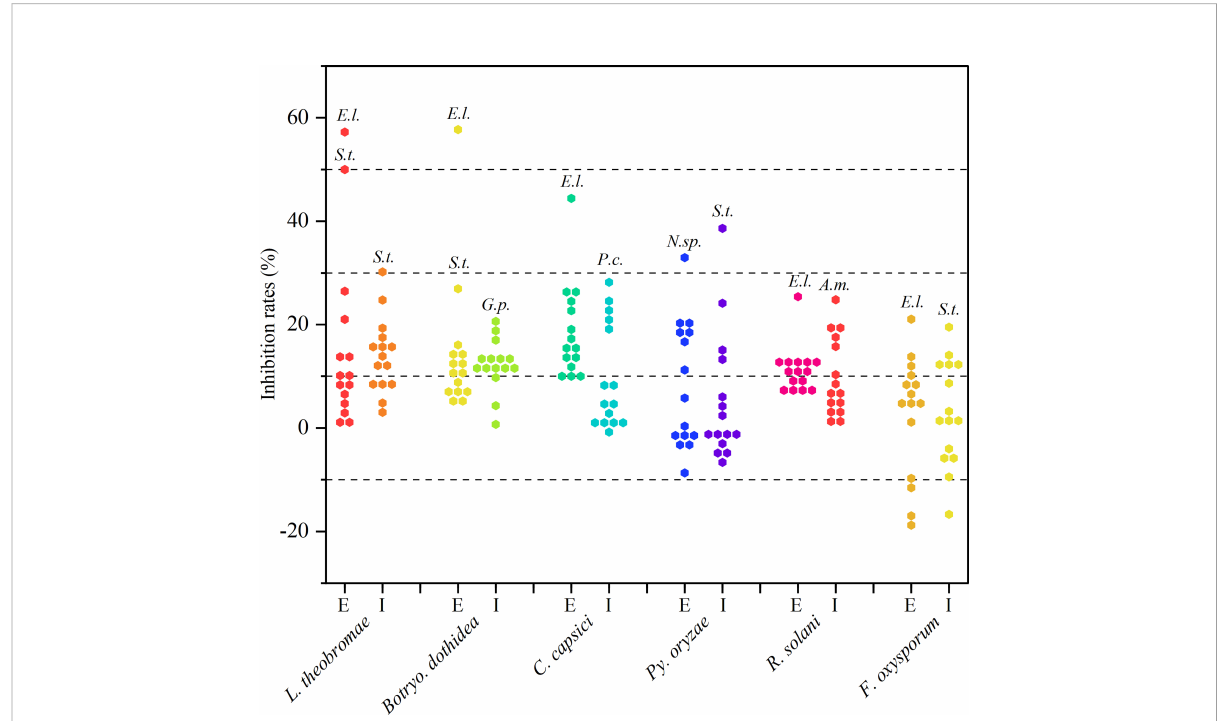
FIGURE 2 Results of re-screening for antifungal activity. E and I indicate extracellular and intracellular metabolites, respectively. A.m. , E.l. , G.p. , N.sp. , P.c. , and S.t. , represent Aureobasidium microstictum HGUP191071, Epicoccum latusicollum HGUP191049, Guignardia psidii HGUP191042, Neofusicoccum sp. HGUP191080, Penicillium crustosum HGUP190031, and Setophoma terrestris HGUP190028,